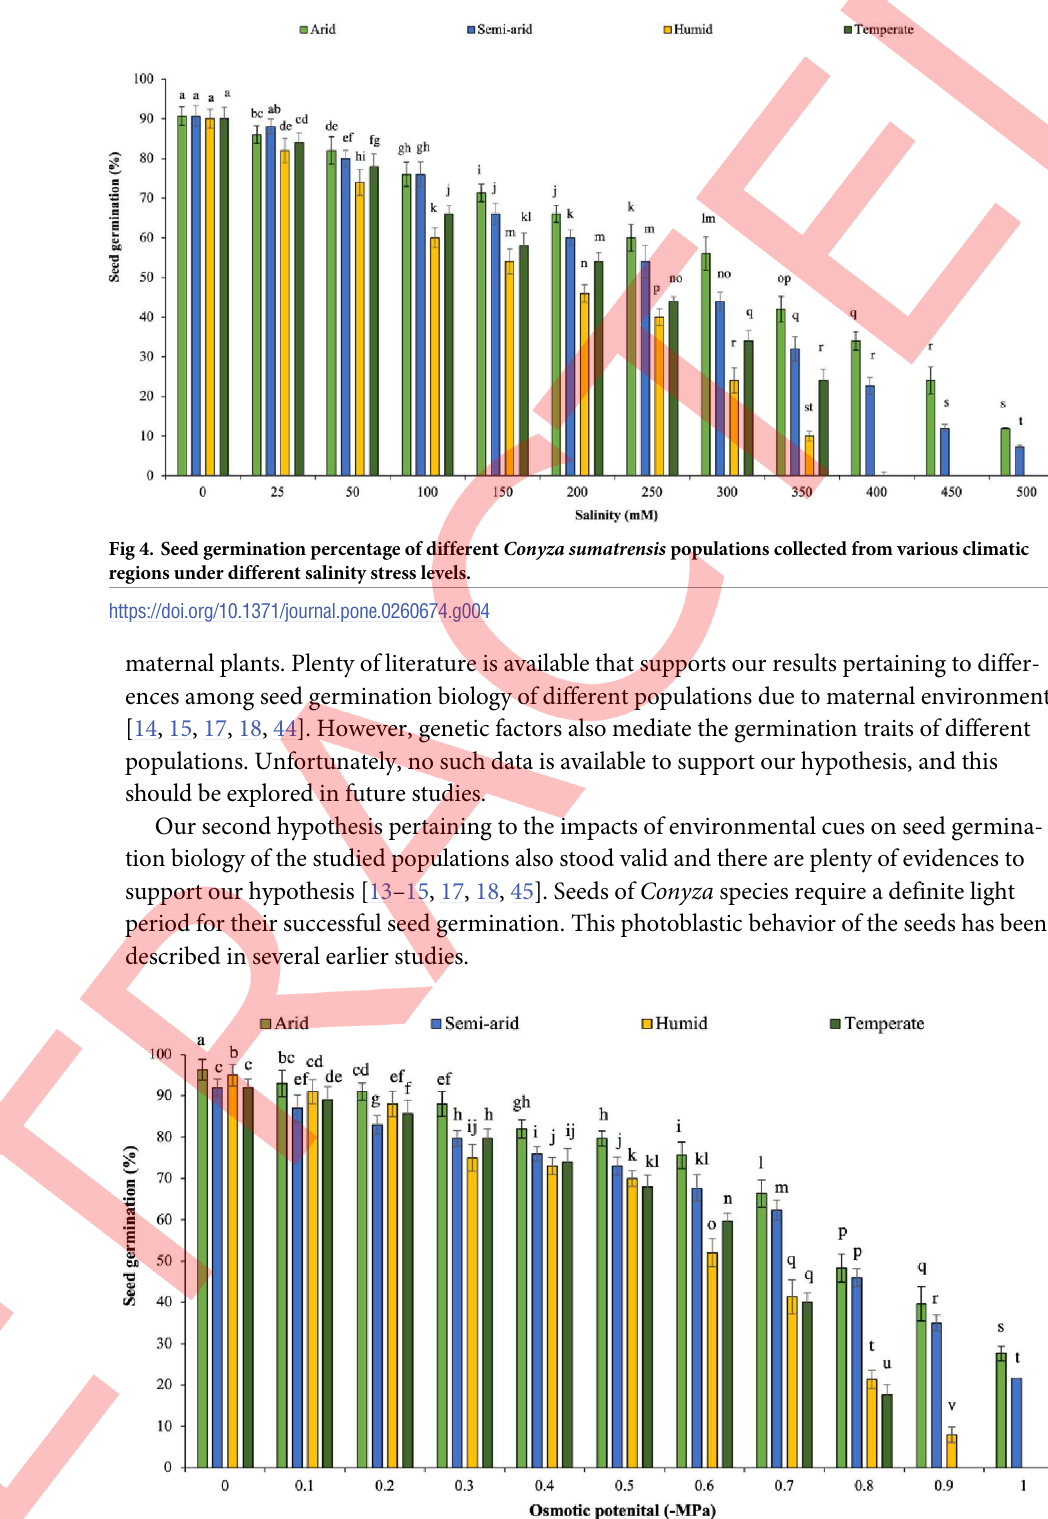
Fig 5. Seed germination percentage of different Conyza sumatrensis populations collected from various climatic regions under different osmotic stress levels.